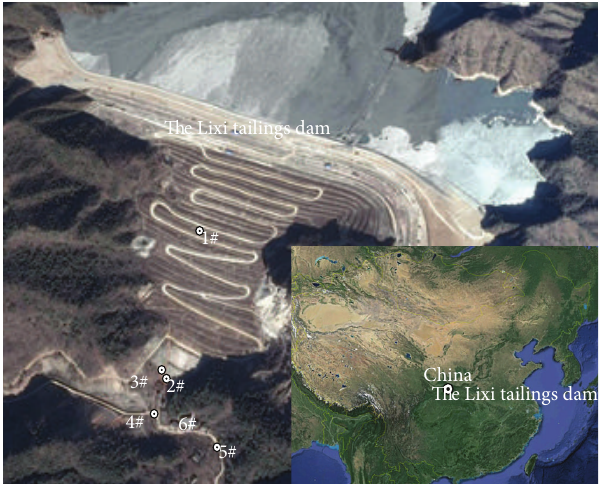
Figure 1: The location of Lixi tailings dam.